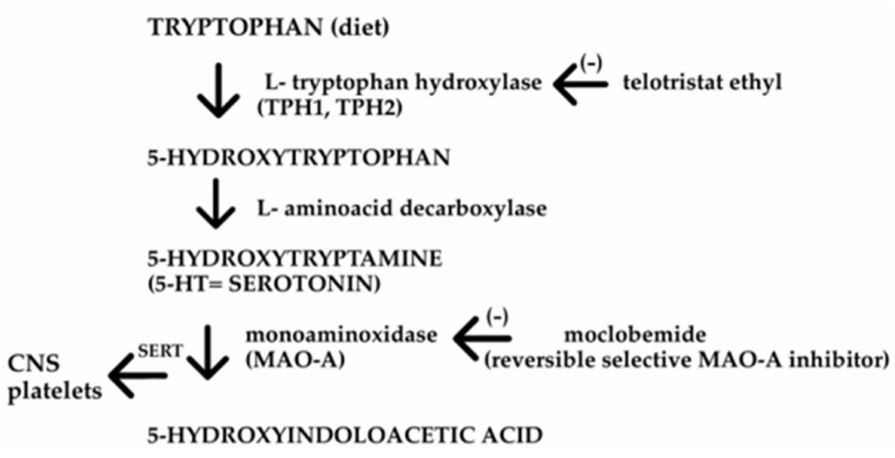
Figure 1. A scheme of serotonin production.